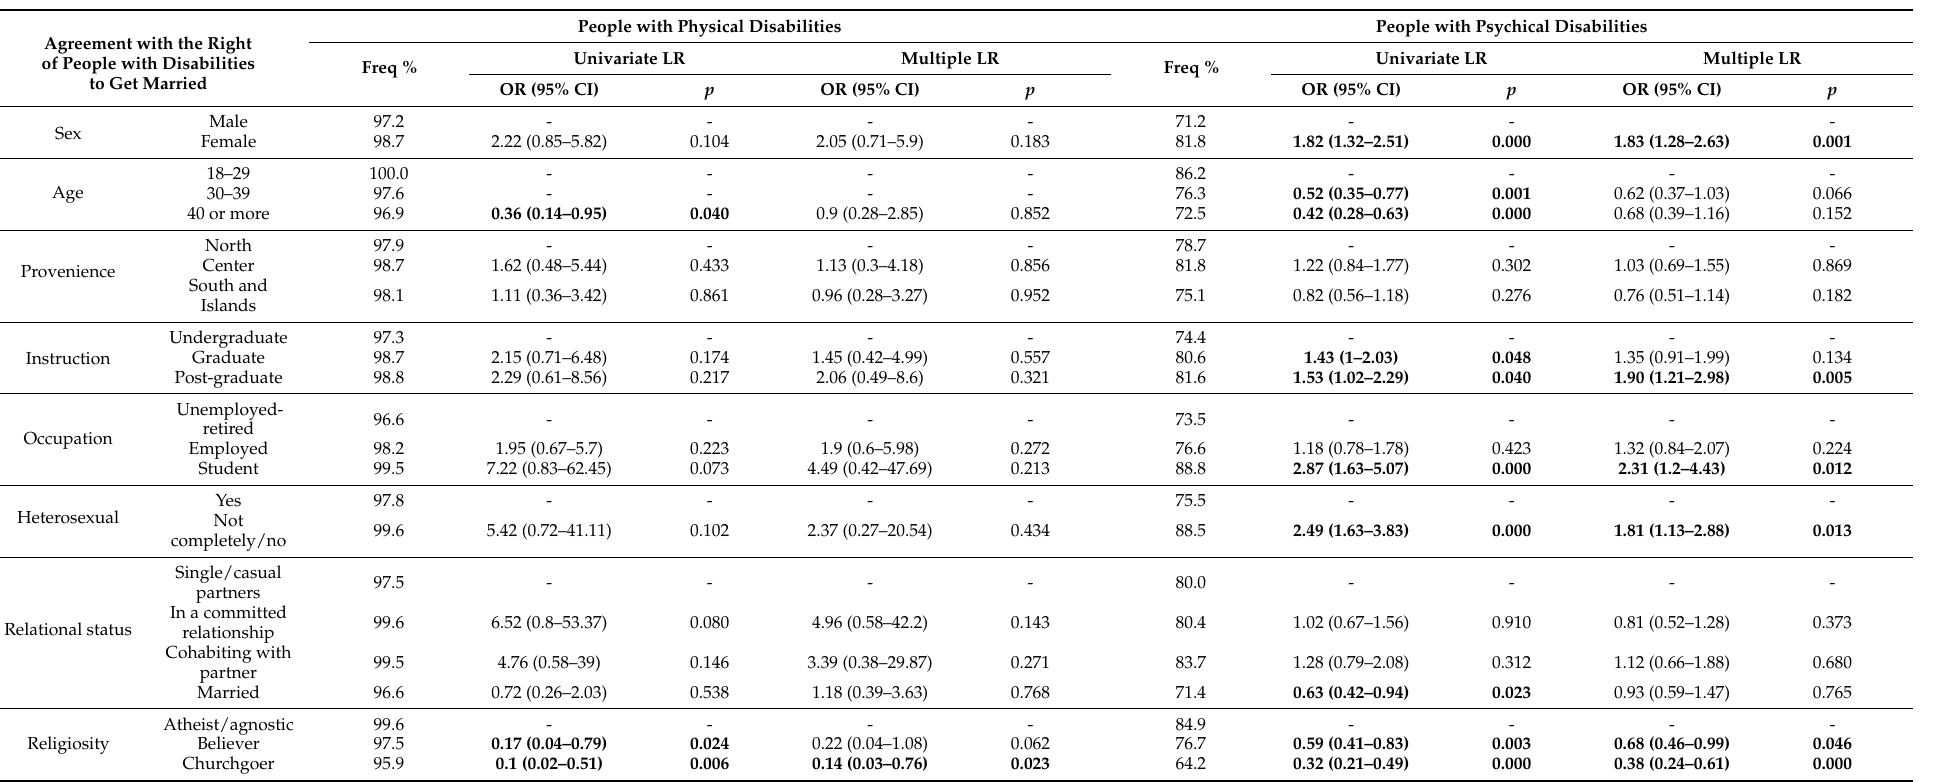
Table 3. Socio-demographic features and percentages of agreement with the right of people with physical and psychical disabilities to get married: Frequencies (in percentages) and results of the univariate and multiple logistic regression analyses. Significant differences with respect to the reference are reported in